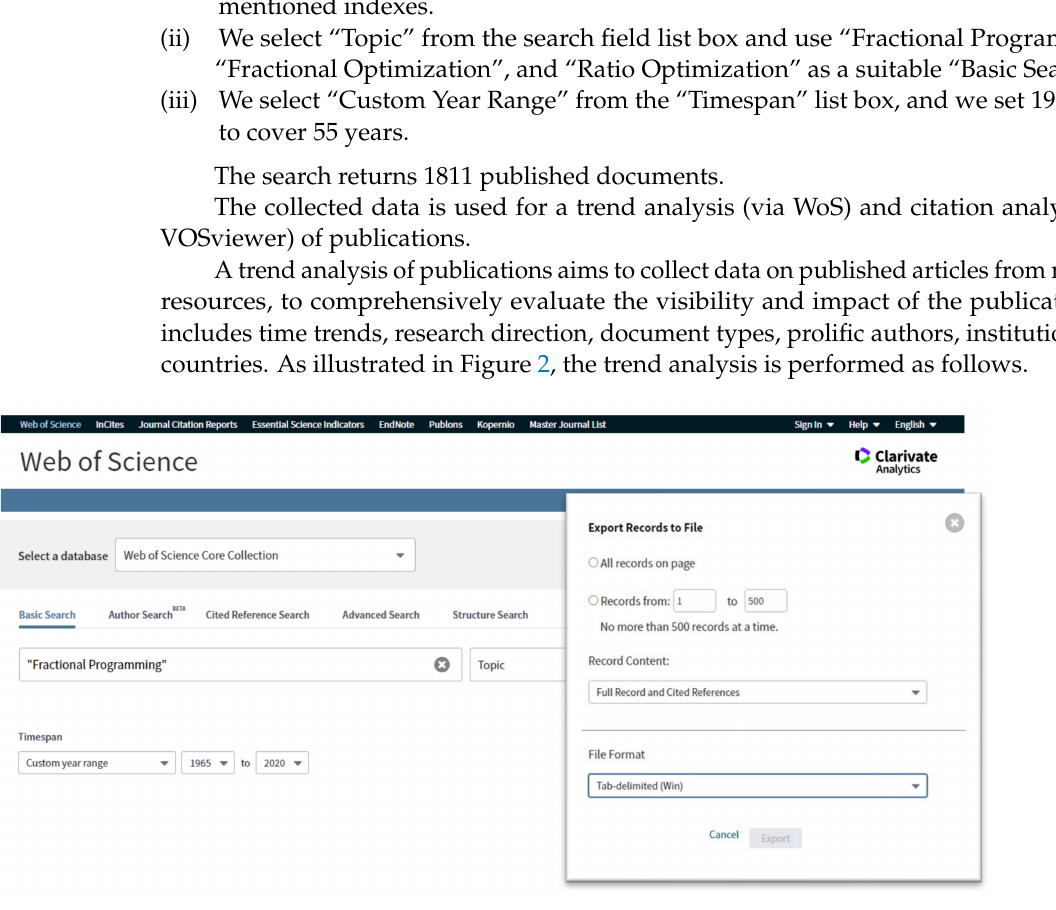
Figure 2. Search settings in